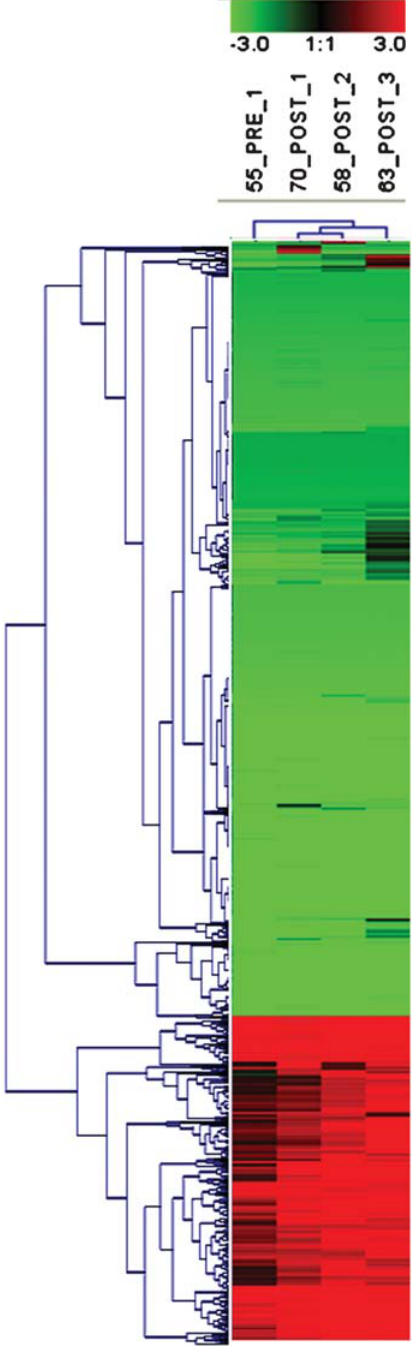
Figure 4. Hierarchical Cluster Analysis. The cluster shown represents 3,117 genes. Each row represents a gene, whereas each column corresponds to a tissue sample. The relative abundance of the gene in the tissue correlates with color intensity (red, induced; green, repressed; black, no change). On the dendogram, post-treated clinical samples clustered